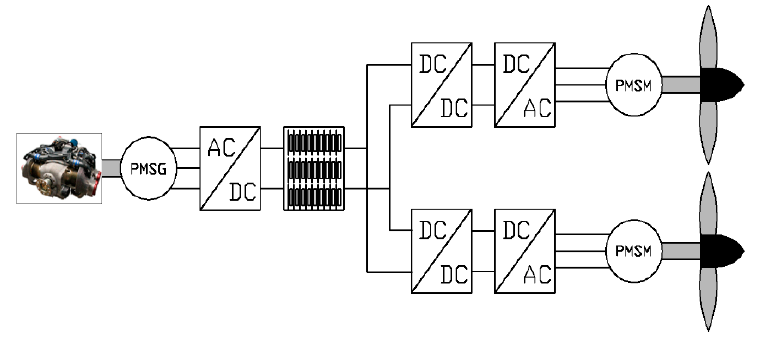
Figure 1. Series-hybrid architecture of the propulsion.